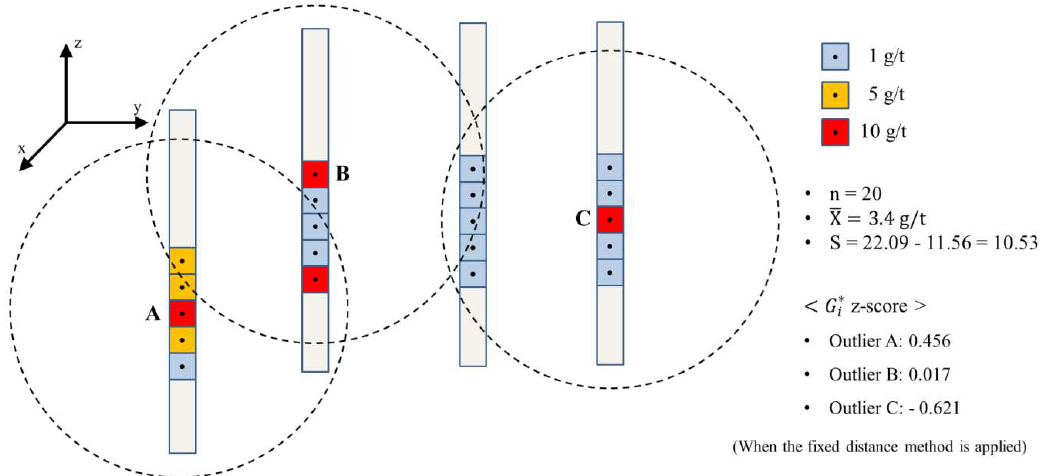
Figure 3. A schematic diagram of the 3D hot spot analysis for borehole data.